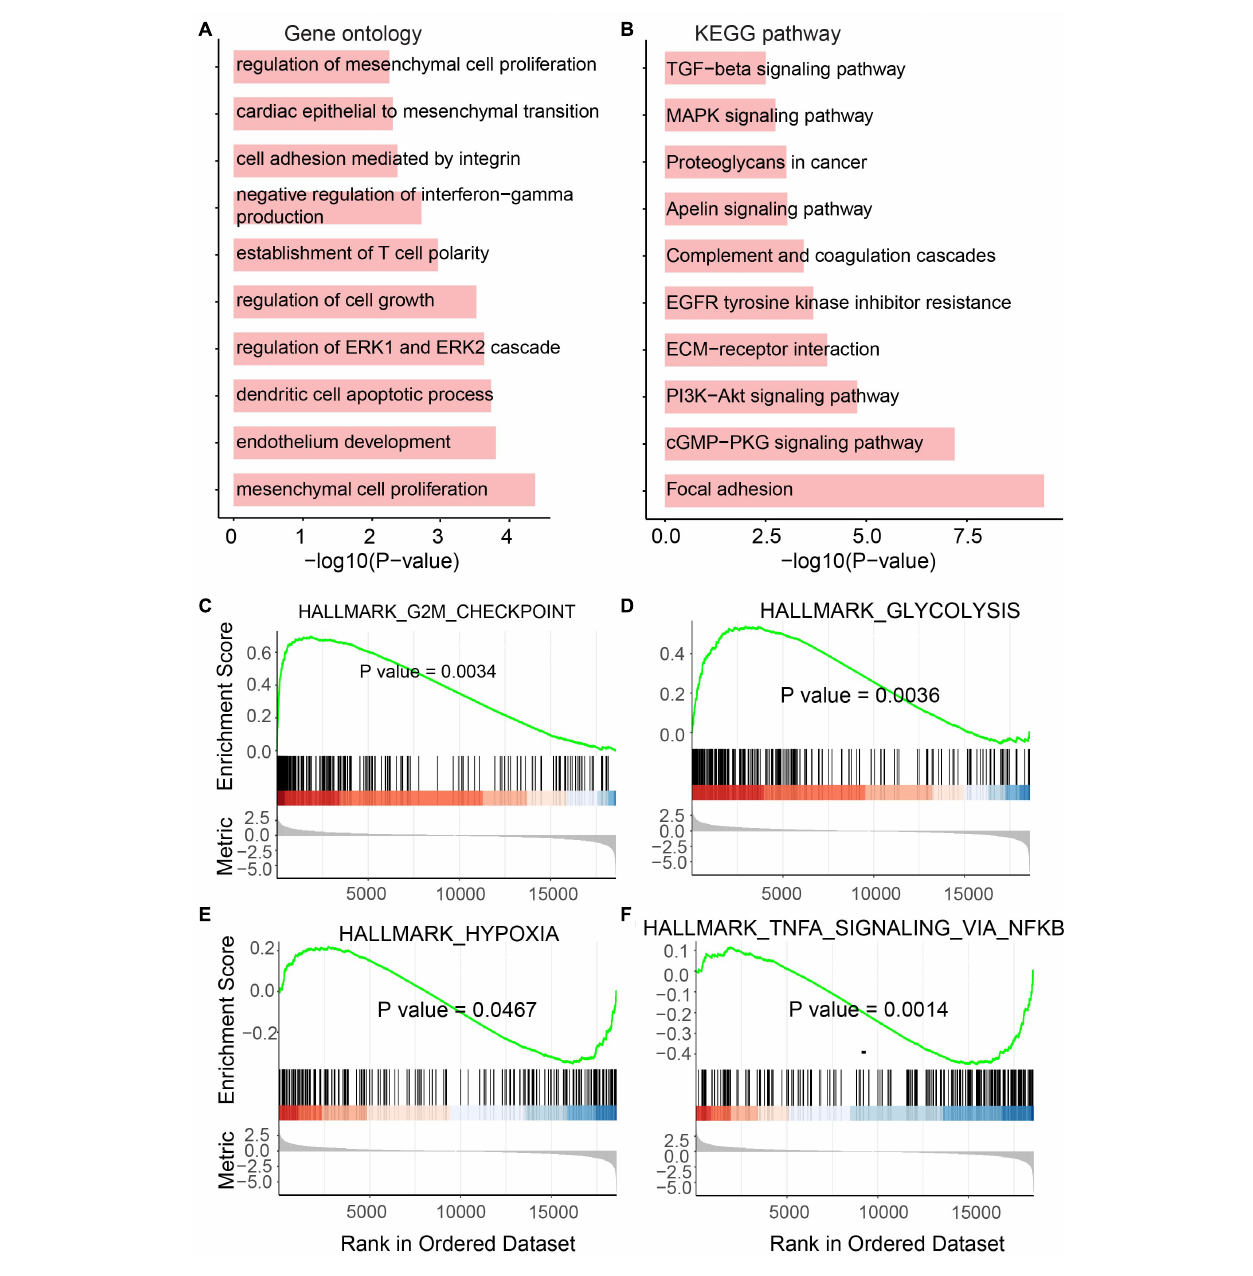
FIGURE 3 | Functional enrichment analysis for differentially expressed mRNAs. (A) Enriched GO terms. (B) Enriched KEGG pathways. (C–F) Results of GSEA